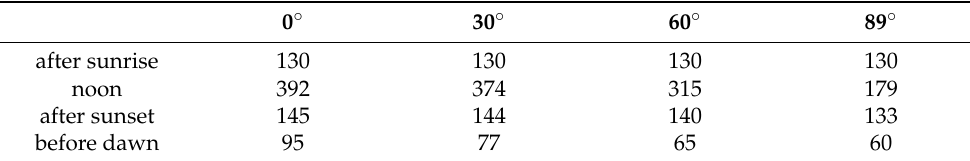
Table 4. Lunar surface temperatures at selected selenographic latitudes and different times of day.